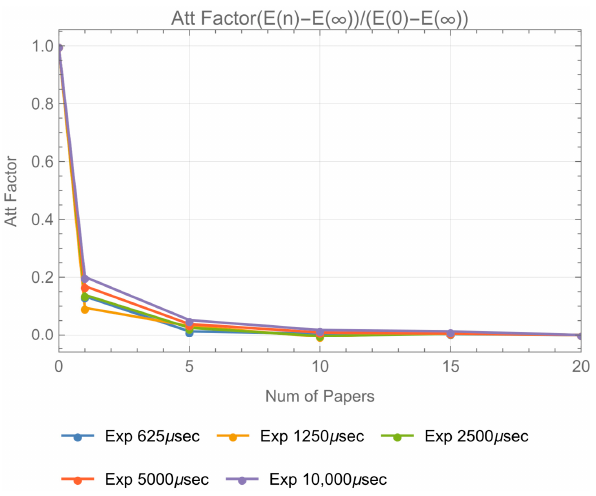
Figure A3. Attenuation factor T p ( n ) .